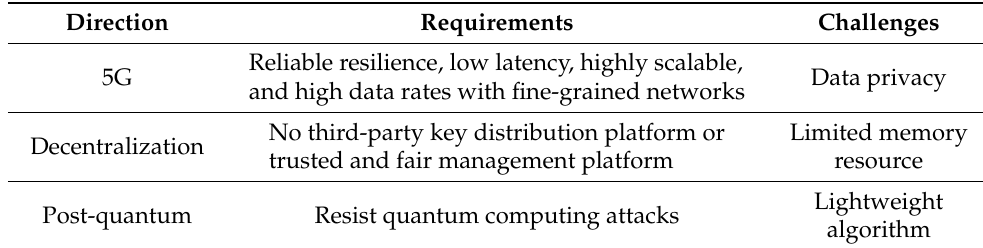
Table 7. Summary of future direction in ZKP-based